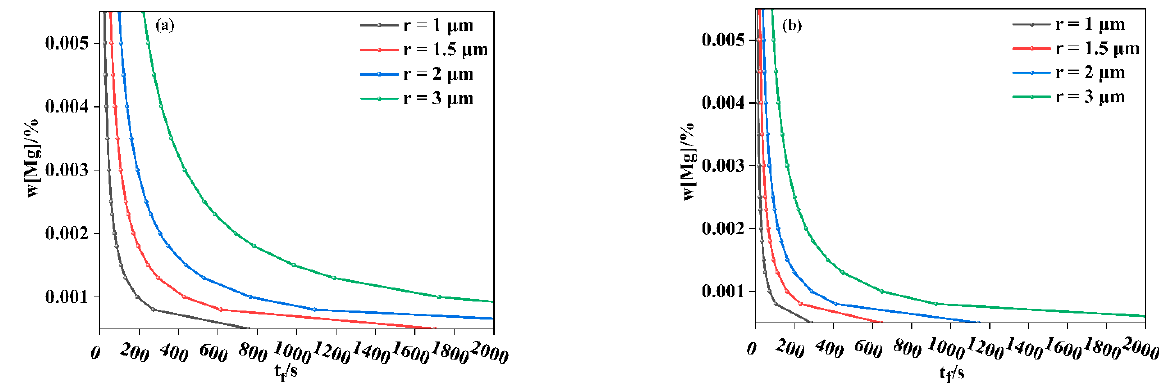
Figure 10. Relationship between Mg content in molten steel and complete modification time of inclusions with different compositions. ( a ) sample M1, ( b ) sample M2.